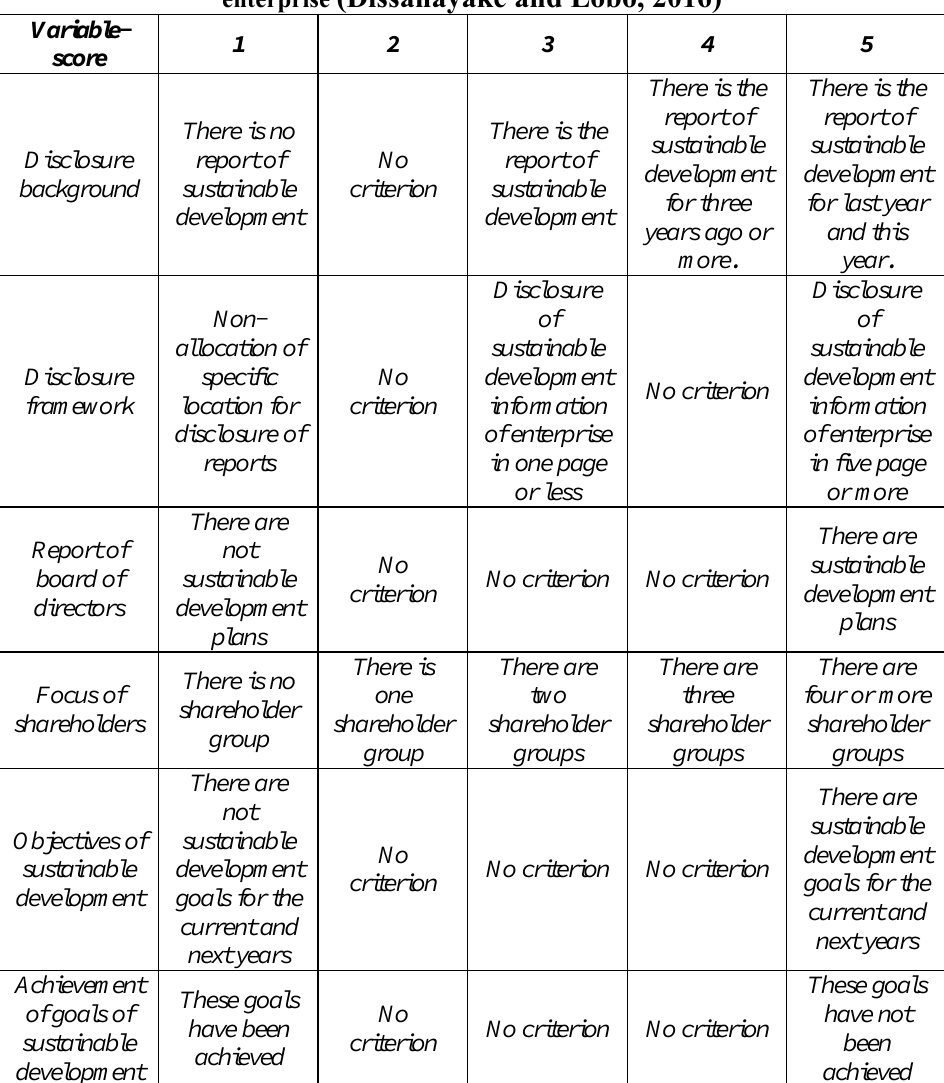
Table 1. Integrated model of sustainable development for social responsibility of enterprise (Dissanayake and Lobo,